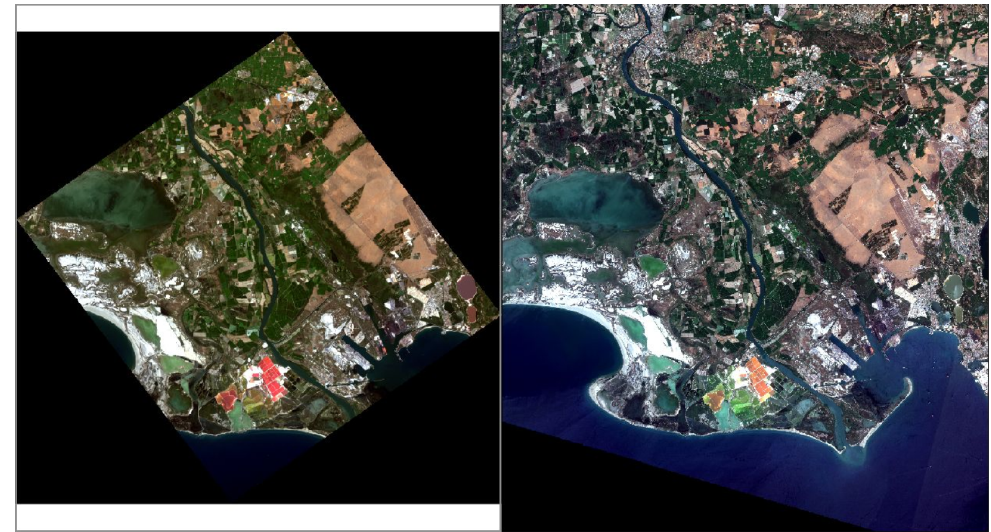
Figure 10. L1C RGB of DESIS ( left ) and Sentinel-2 ( right ), acquisitions on 15 August 2020 over La Crau RadCalNet site.